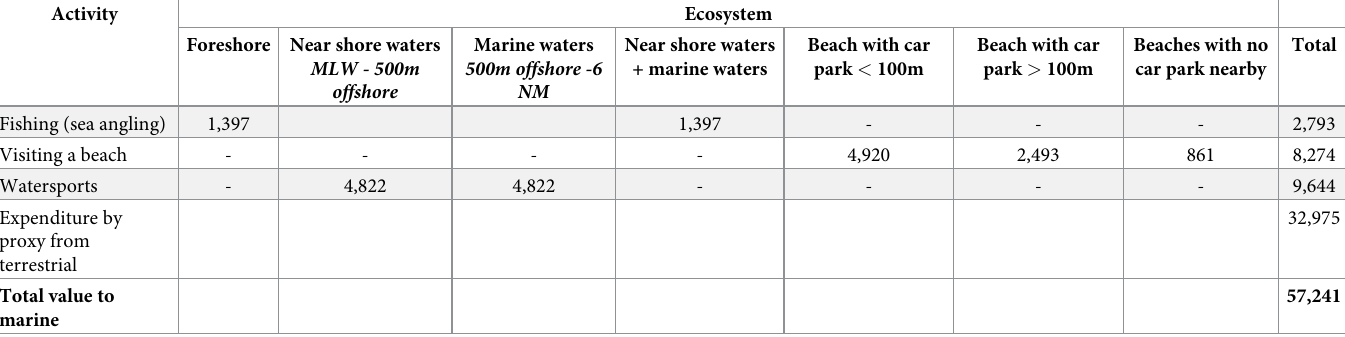
Table 6. Ecosystem breakdown of expenditure attributable to natural capital for 3 marine activities in Pembrokeshire (£